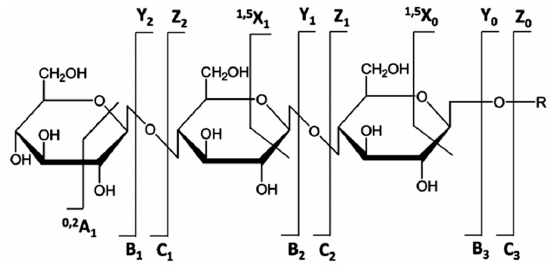
Figure 4. Nomenclature for the fragmentation of glycans; A and X ions represent cross-ring fragments and B, C, Y and Z are glycosidic fragment ions. (Adapted from Domon and Costello) [136]. Glycan fragmentation patterns vary depending on the ion acquisition polarity mode. In positive mode, ionization of glycans results in the formation of [M+H] + and [M+Na] + pseudomolecular ions and adducts. CID fragmentation of glycans generates abundant B/Y type glycosidic fragments. Although the B/Y ions facilitate glycan sequencing, they provide little information on linkage and positional isomer information [137]. Derivatization, such as permethylation, coupled with tandem MS have been employed for elucidation of isomer structure [138,139]. Figure 5A shows the MS/MS fragmentation spectrum of an unusual core fucosylated high mannose structure ( m / z = 751.9), generated in positive ion mode, observed in CRC tumor tissues [35]. The MS/MS fragment ions at m / z = 692.2 and 854.3 are diagnostic for the presence of core fucose, while m / z = 670.7, 589.7, 508.7 and 427.7 indicate subsequent loss of mannose residues.